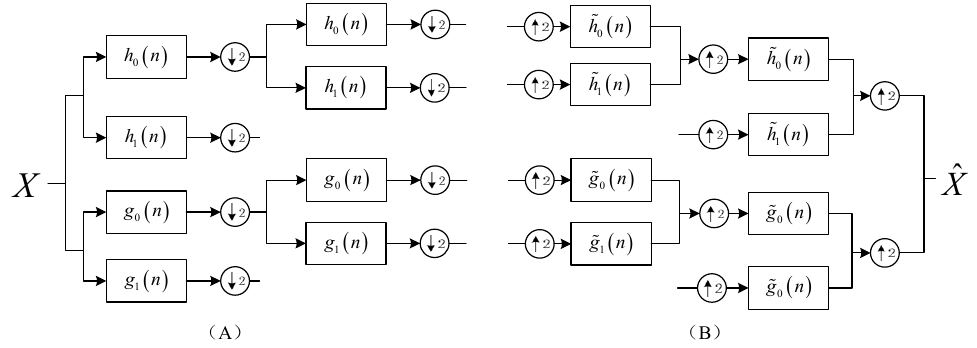
Figure 1. Dual-tree complex wavelet transform: ( A ) analysis filter bank; and ( B ) synthesis filter bank. Bivariate shrinkage function was proposed by Sendur L and Selesnick I W [45] in 2002. The DTCWT with bivariate shrinkage function can be described as follows.